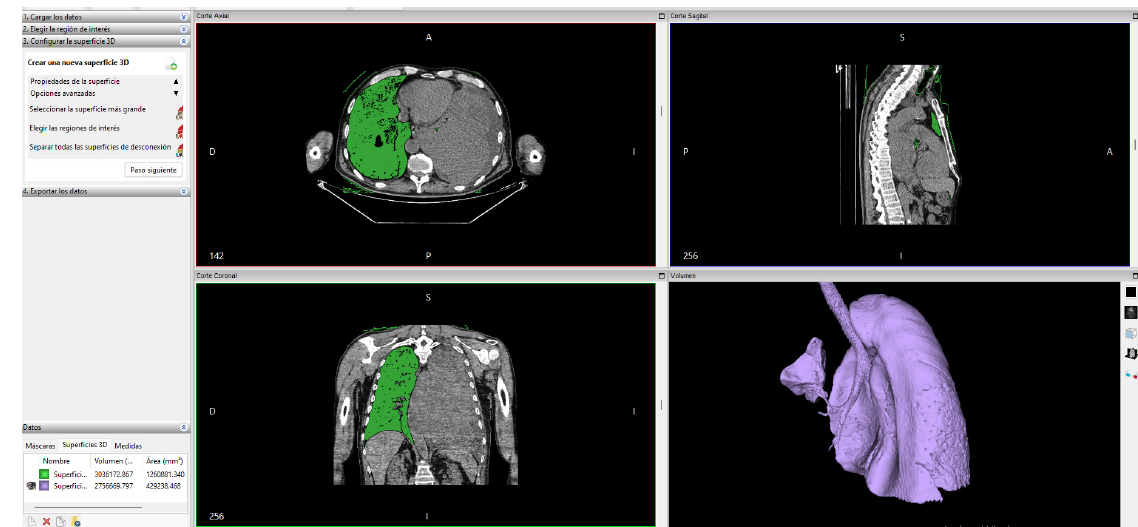
Figure 4. Lung segmentation in Invesalius.